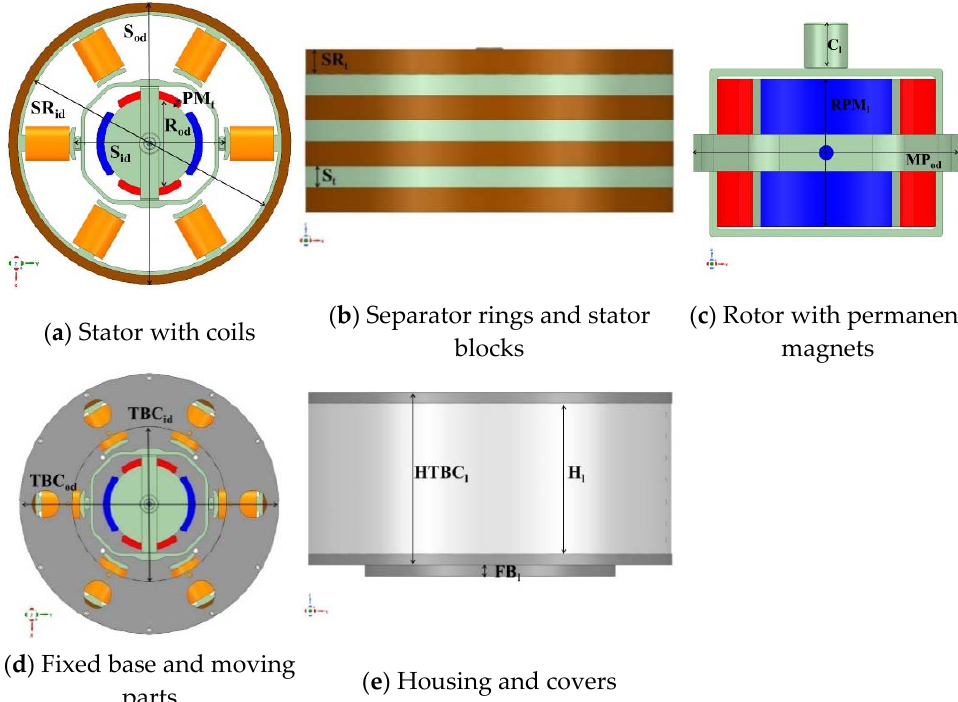
Figure 2. Structures of the motor stator with coils ( a ), separator rings and stator blocks ( b ), the rotor with permanent magnets ( c ), fixed base and moving parts ( d ), and a housing and covers ( e ).